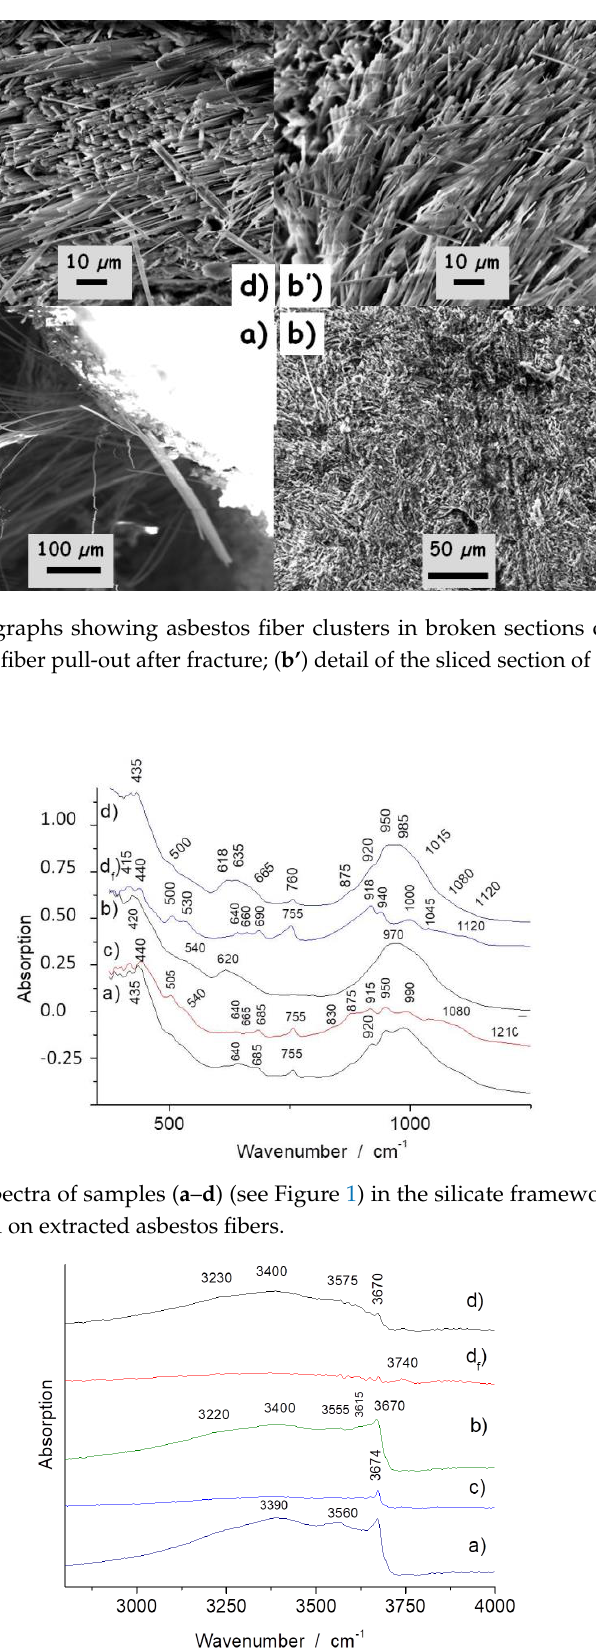
Figure 4. FTIR ATR spectra of samples ( a – d ) (see Figure 1) in the O-H/H 2 O spectral range; ( d f ) spectrum recorded on extracted asbestos fibers.